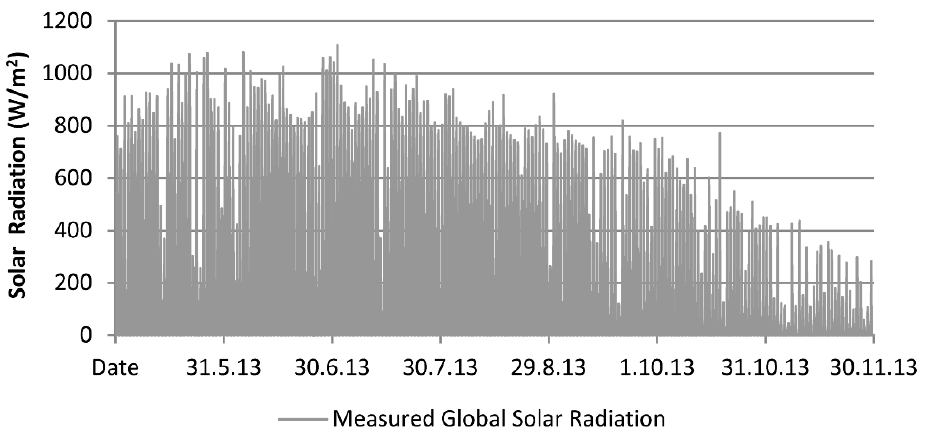
Figure 4. Global Solar Radiation (W / m 2 ). Measured data for the locality of Košice. Displaying the selected period from May 2013 to December 2013 [28,29].